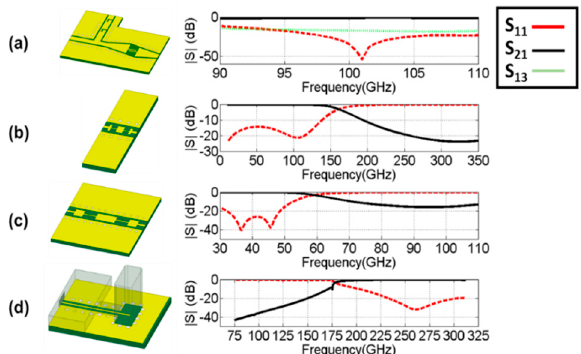
Figure 5. 3-D perspective view and predicted response of passive circuits: ( a ) Bias-T, ( b ) stepped low pass filter for LO, ( c ) stepped low pass filter for DC Bias of SBD and ( d ) coplanar to standard waveguide WR-3 transition.